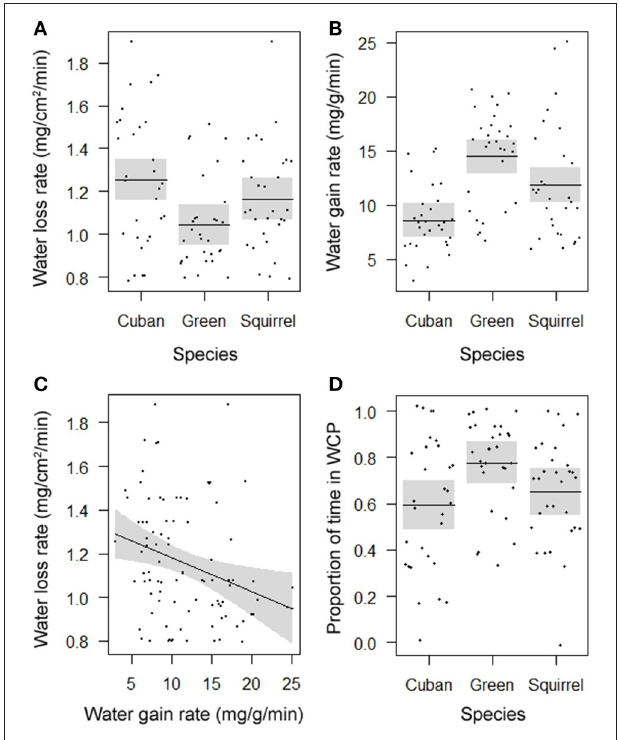
FIGURE 1 | Partial residual plots with lines depicting means (in A , B , D ) or regressions (in C ) and 95% confidence bands (shaded), controlling for all factors in the statistical models that are not shown in the figures, showing the significantly different rates of (A) evaporative water loss and (B) water uptake for three species, (C) the significant correlation between these rates for individual frogs, and (D) significant differences in the proportion of time spent in the water-conserving posture (WCP) among three